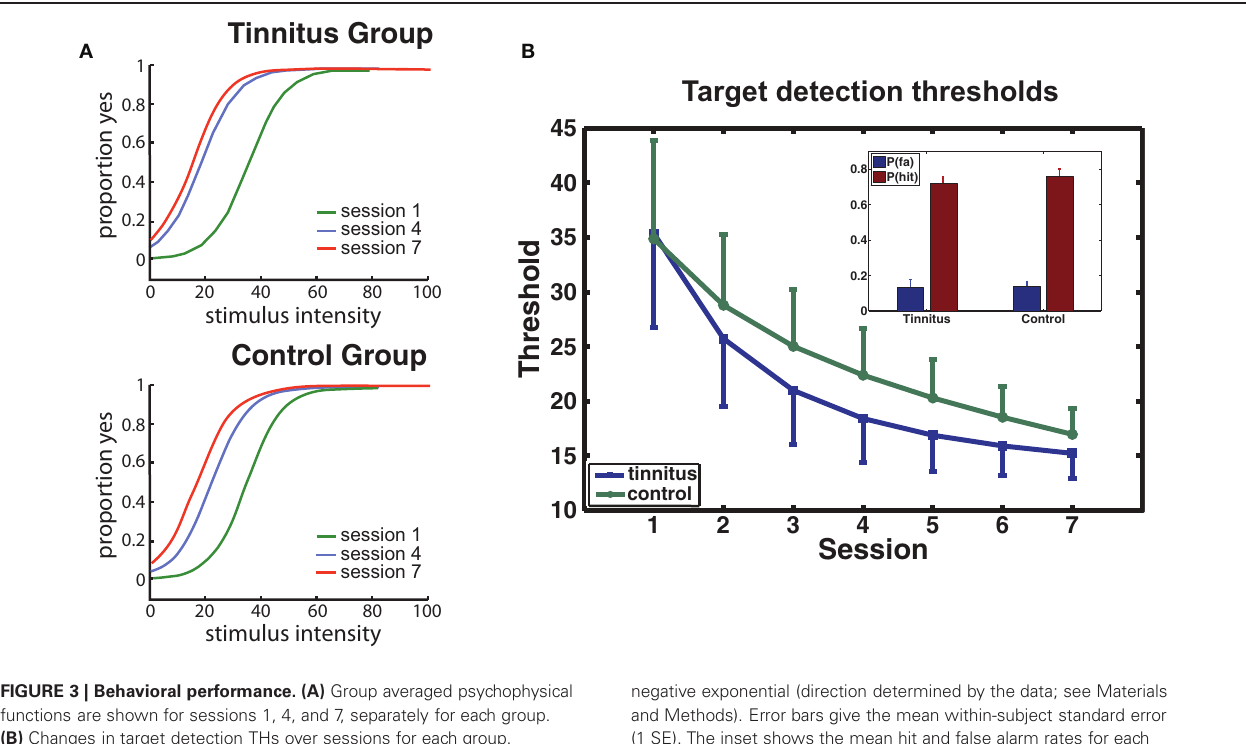
FIGURE 3 | Behavioral performance. (A) Group averaged psychophysical functions are shown for sessions 1, 4, and 7, separately for each group. (B) Changes in target detection THs over sessions for each group. The model used for curve fitting of each participant’s data applied a